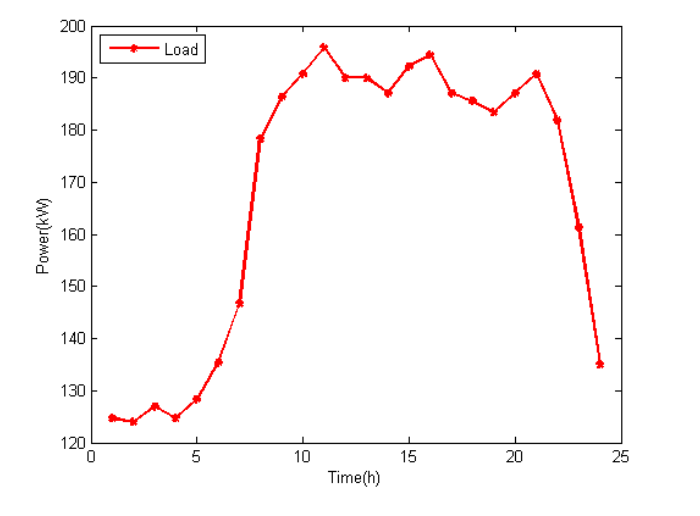
Figure 3. Forecast values of load. Table 2. Parameters of